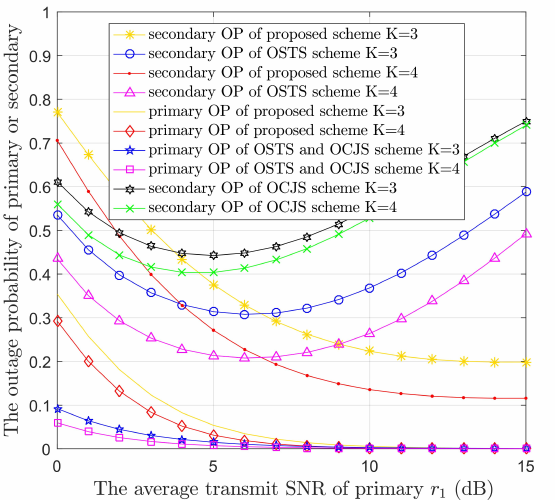
Figure 3. The OPs of PUs or SUs versus the average transmit SNR of primary ( r 1 ) in the three protocols with different the number of STs ( K ).